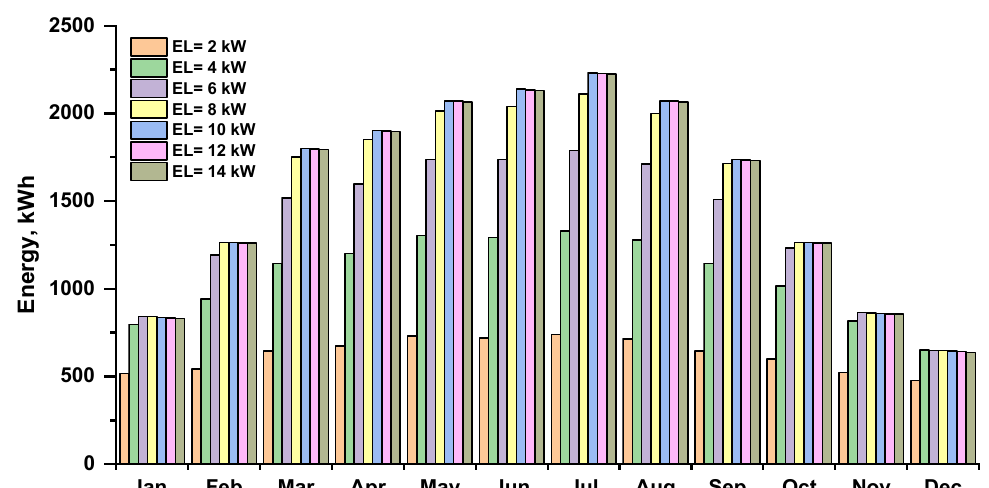
Figure 7. Monthly energy consumption by the electrolyzer at various capacities.